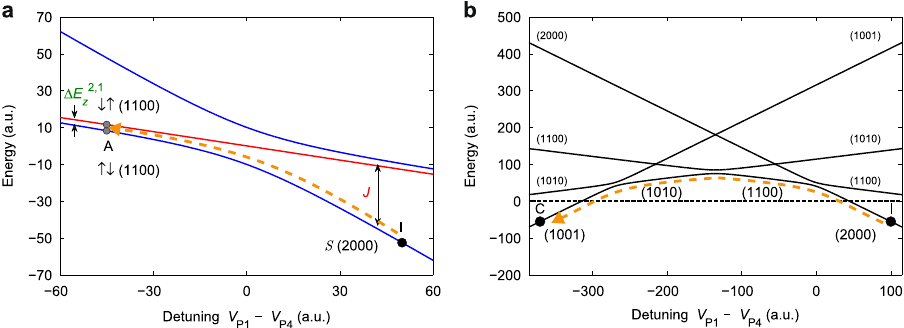
Fig. 2 Adiabaticity requirements for shuttling. a Schematic energy diagram for shuttling from (2000) (I) to (1100) a . The rise time of the applied gate voltage pulse is chosen such that the charge motion is adiabatic with respect to the inter-dot tunnel coupling, causing one of the electrons to move to dot 2, but non-adiabatic with respect to the spin Hamiltonian causing the spin singlet state to be preserved. As a p (1100) (orange dashed arrow). b A similar energy diagram when linearly moving consequence, the system is taken from S (2000) to "#(cid:4)#" ffiffi 2 between points I and C in Fig. 1b (Supplementary Information Section II). Lines are depicted for spin-less states. When inter-dot tunnel rates are tuned to be larger than the rate of change of the detuning (controlled by the ramp rate of V P1 − V P4 ) and the dot-reservoir tunnel rates, the charge state adiabatically follows its original energy branch without crossing over to other branches and without the electron escaping to the reservoir (the horizontal dashed line indicates the Fermi-level). Furthermore, as in panel a , the detuning ramp rate must be fast enough such that the spin singlet is preserved during the charge